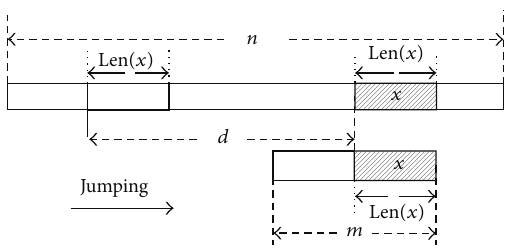
Figure 7: The perfect matching of pattern bit string.